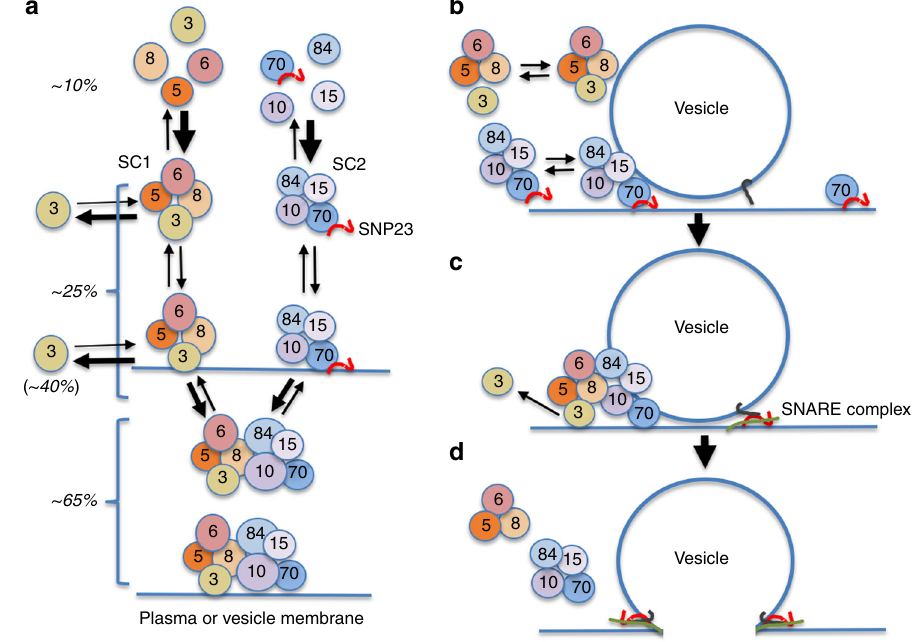
Fig. 9 Model for exocyst subunit assembly/disassembly and vesicle tethering. a Schematic of subunit interactions within the cell. Subunits are shown as circles, SC1 and SC2 mark the two subcomplexes, and arrow weights represent relative on or off rates. SNP23 associates with EXO70 but is not co- precipitated with SEC5. Detailed molecular interactions with membranes are not illustrated and the diagram is not to scale. Percentages are the estimated proportions of each state, derived from corrected TIRFM and FCCS data. Octameric complex abundance = (SEC5 + EXO70) colocalization or cross- correlation; tetrameric subcomplex abundance = (SEC5 + SEC8) – (SEC5 + EXO70); and free subunit abundance = total – octamer – tetramer. Free SEC3 is calculated from total – (SEC3 + SEC5). We do not know what fraction of octamer is actually a heptamer lacking bound SEC3. FCCS data suggest that about 50% of exocyst is very slowly diffusing within the cell, likely associated with vesicles, estimated from calculating the hydrodynamic radius of the slow diffusing species. We propose that the individual subcomplexes can interact weakly with membranes but bind membrane more ef fi ciently when assembled into an octamer. SEC3 interacts with SC1 less robustly than do the other subunits. b Individual subcomplexes can associate with vesicles at the PM but cannot trigger fusion. Percentages show estimated relative abundances at the membrane, based on TIRFM data. c Interaction of the subcomplexes to form octamer stabilizes tethering, and release of SEC3 precedes fusion. d Fusion is accompanied by rapid release of the